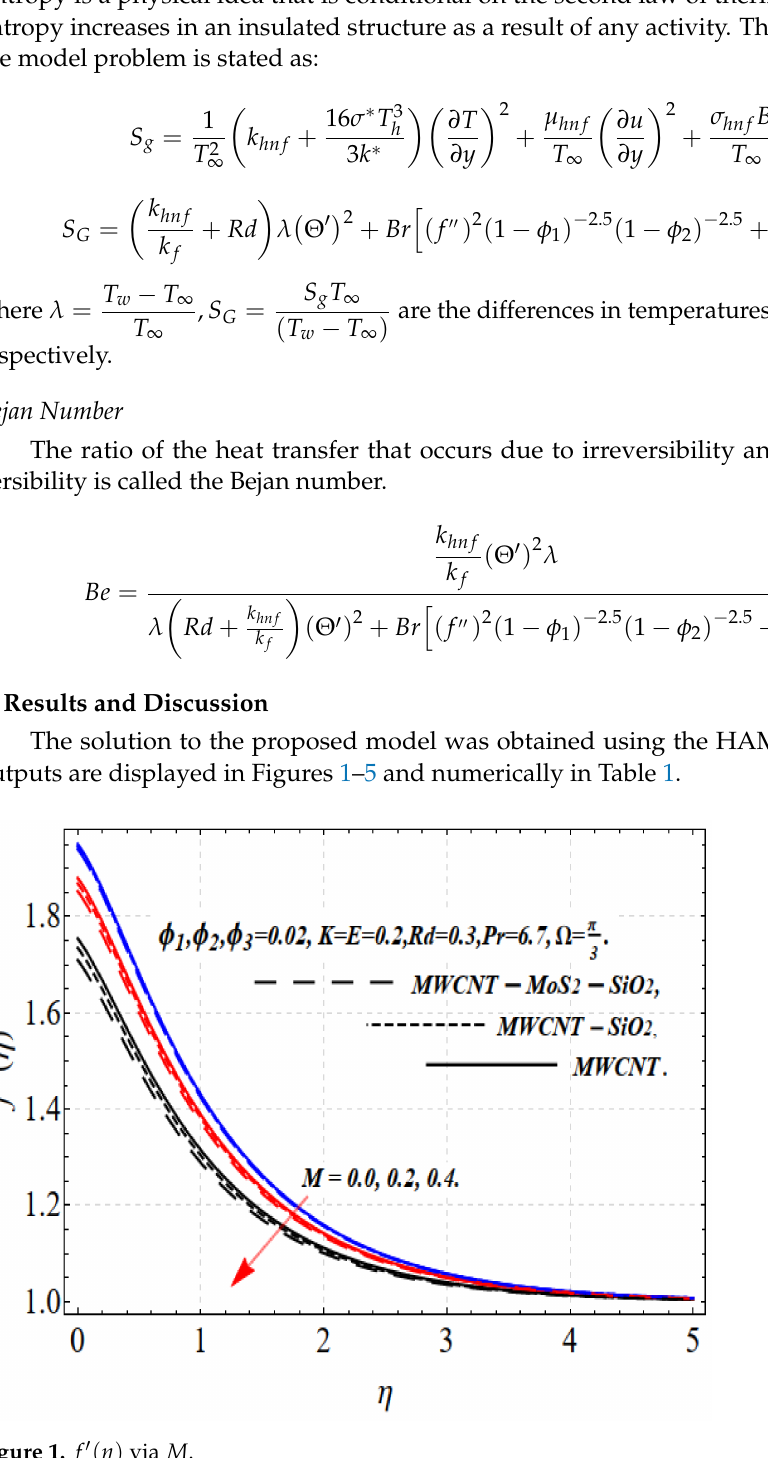
Figure 1. f (cid:48) ( η ) via M